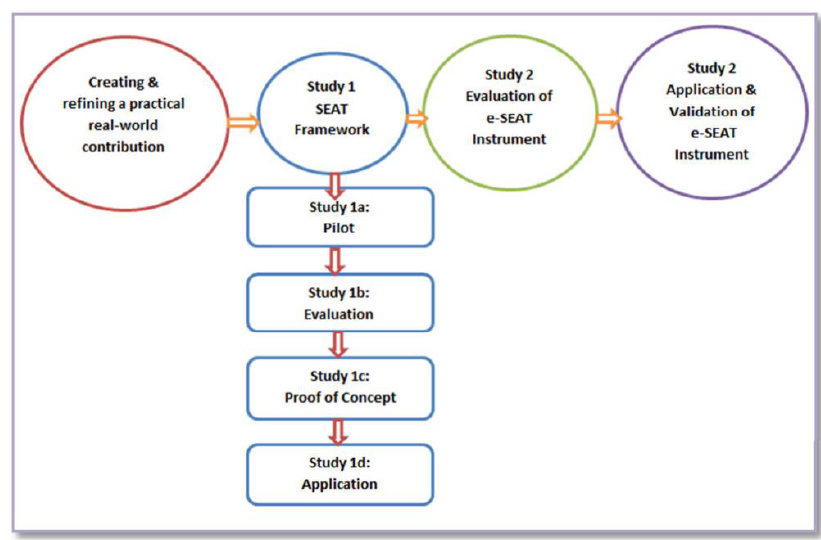
Figure 2. Action research applied to SEAT and e-SEAT instrument. In Study 1, with four sub-studies, sets of participants inspected the SEAT Framework from varying perspectives to suggest extensions and refinements and to propose further criteria. After SEAT had been converted to the online e-SEAT Instrument, e-SEAT was investigated and refined. Study 2 evaluated the Instrument itself. Study 3 applied e-SEAT to evaluate specific MCQ systems, thus validating it by use. Participants were employees at HEIs in South Africa, particularly in computing-related disciplines: Computer Science, Information Systems, and Information Technology, but the findings are relevant to other disciplines